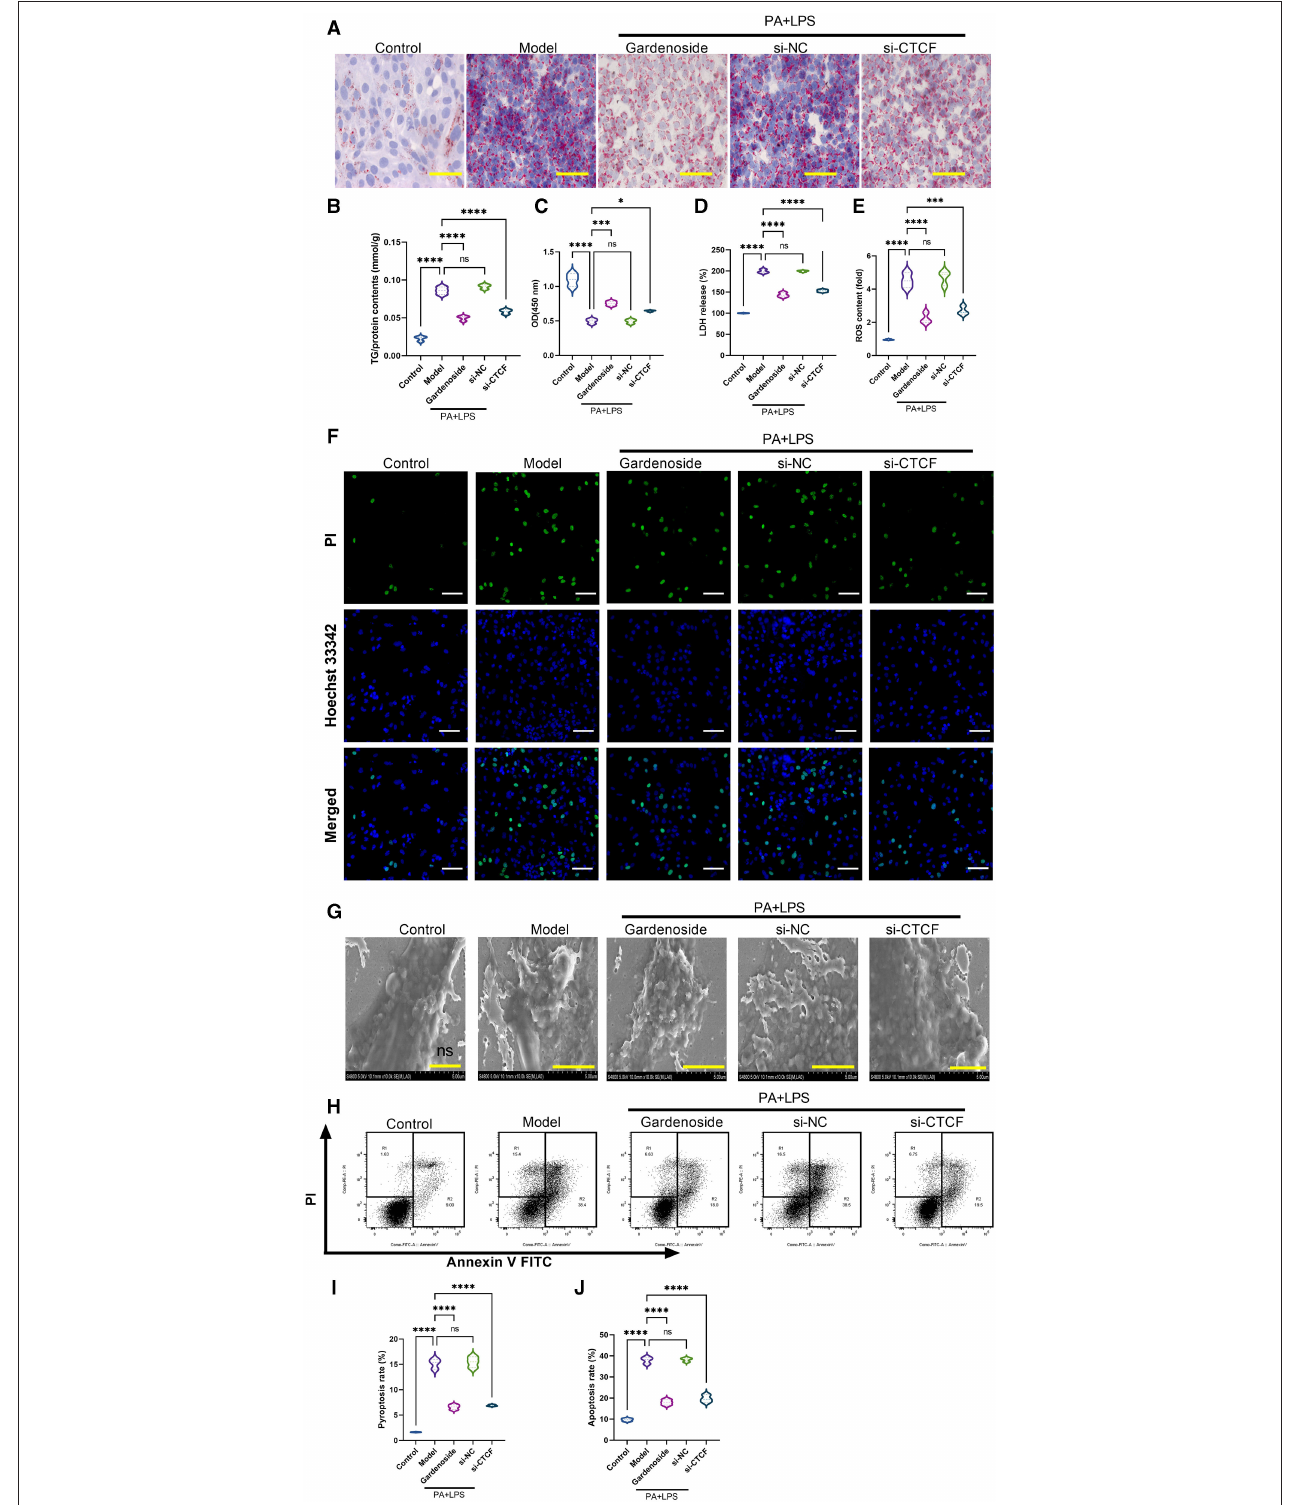
FIGURE 3 | Gardenoside and CTCF silencing inhibited lipid accumulation, intracellular reactive oxygen species (ROS), LDH release, apoptosis, and pyroptosis in the cell model of NAFLD. (A) Oil Red O staining showing lipid accumulation level in AML cells of control, model, gardenoside, si-NC, and si-CTCF groups (Scale bar: